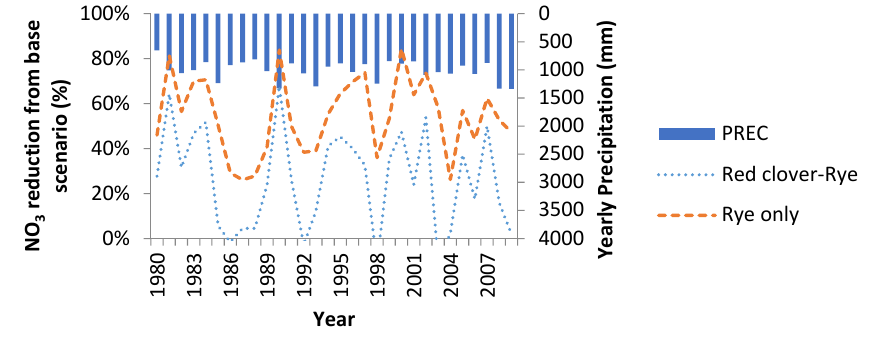
Figure 10. Percent discrease in nitrate discharge simulated at outlet compared with base scenario.